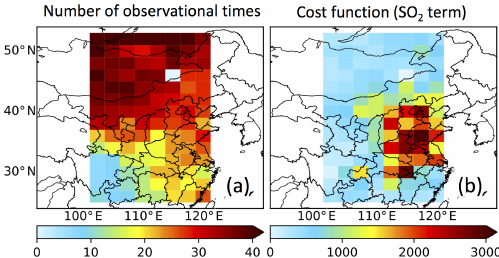
Figure 2. Panels (a) and (b) show the numbers of the OMPS over- pass time that provides SO 2 VCD retrievals and the SO 2 term in the cost function at the first iteration, respectively, in October